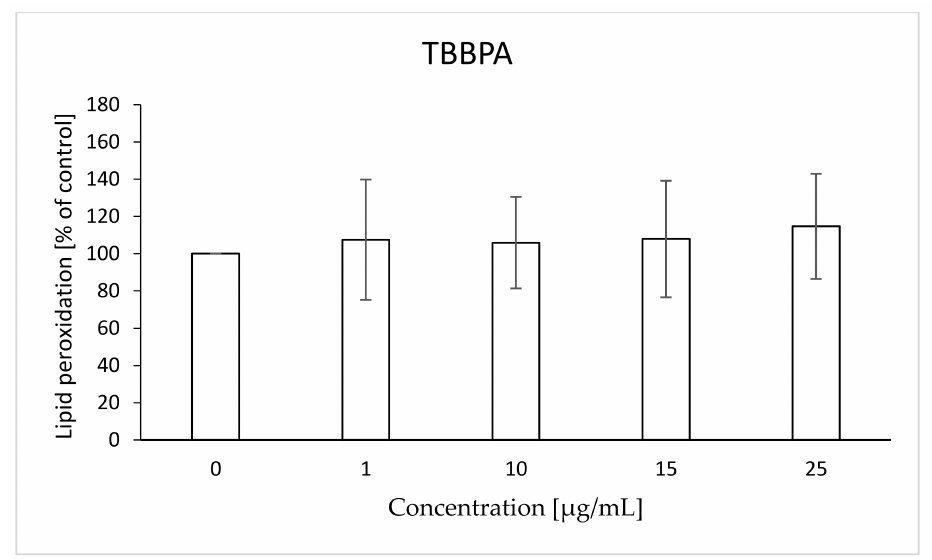
Figure 7. Lipid peroxidation in human control erythrocytes and the erythrocytes incubated with TBBPA at 1 to 25 µ g/mL for 48 h.